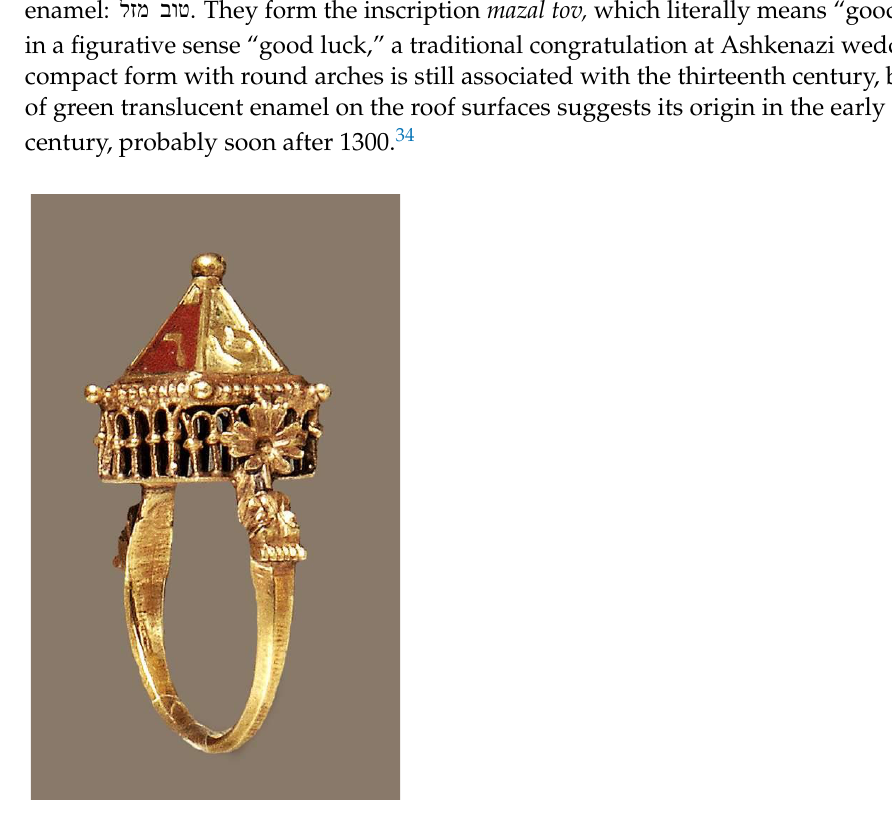
Figure 2. Jewish Wedding Ring, Colmar Treasure (around 1300), © B. Stefan, Thuringian State Office for Heritage Management and